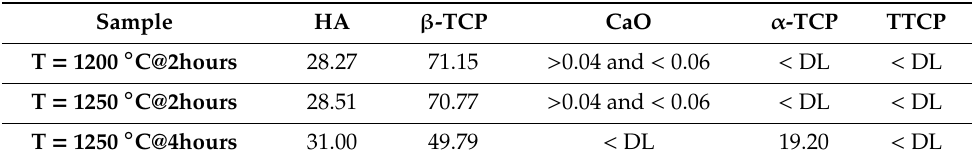
Table 2. Quantitative evaluation of phases, as obtained by X-ray di ff raction (XRD). Values are expressed as percentages (%). DL: detection